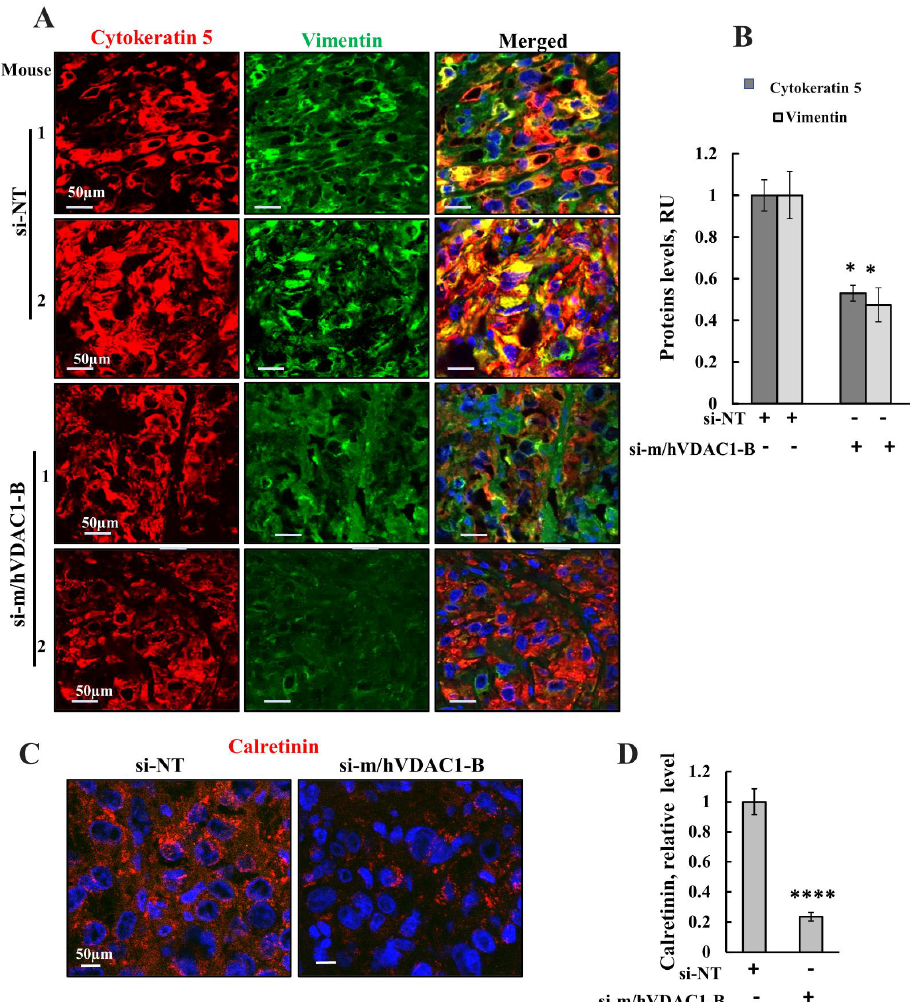
Figure 9. VDAC1 expression depletion decreased the expression of proteins associated with differentiation. Representative immunofluorescence images of sections from H226 cell-derived tumors treated with si-NT or with si-m/hVDAC1-B stained for cytokeratin 5 and vimentin ( A ) and their quantification ( B ), calretinin ( C ), and its quantification ( D ). The results are the means ± SEM, * p ≤ 0.05; *** p ≤ 0.001 .